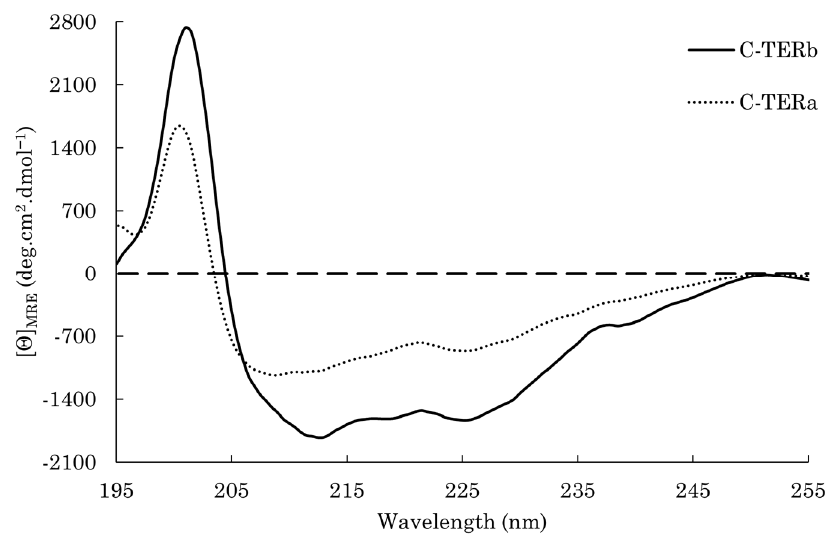
Figure 2. Far-UV CD spectra of C-TERb (solid line) and C-TERa (dotted line) in TBS at ~20 ◦ C Figure 2. Far ‐ UV CD spectra of C ‐ TERb (solid line) and C ‐ TERa (dotted line) in TBS at ~20 °C (C C ‐ (C C-TER = 10 µ M). TER = 10 μ M). Table 1. BeStSel secondary structure content estimations and fit-associated RMSD values of C-TERb Table 1. BeStSel secondary structure content estimations and fit ‐ associated RMSD values of C ‐ TERb and C-TERa (C C-TER = 10 µ M) incubated in TBS at ~20 ◦ C for 0 h, 24 h, 48 h, 72 h, and 96